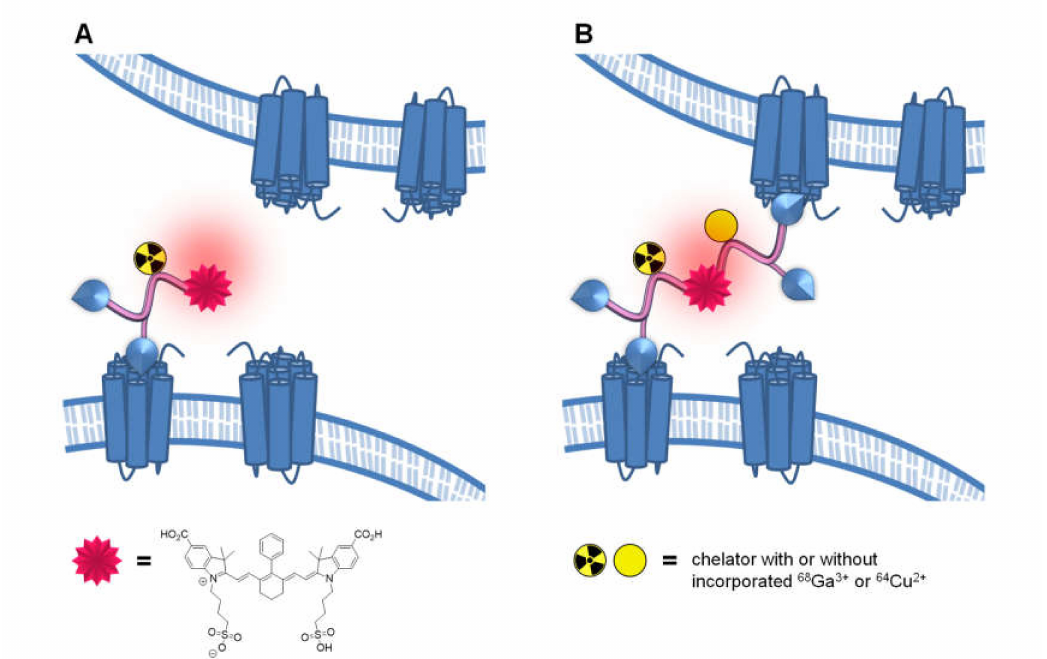
Figure 1. Schematic presentation of the study concept, investigating the influence of a negatively charged hybrid multimodal imaging unit in a PESIN dimer and tetramer on the GRPR binding parameters of the respective bioconjugates. Peptide multimers can result in higher target affinities than monomers, as they can bind with higher probability to the receptor, due to the forced proximity effect ( A ), or by simultaneous binding ( B ). The developed synthetic approach for the peptide multimers builds on a MIU design utilizing the NIR fluorescent dye as a symmetrical branching unit for the assembly of